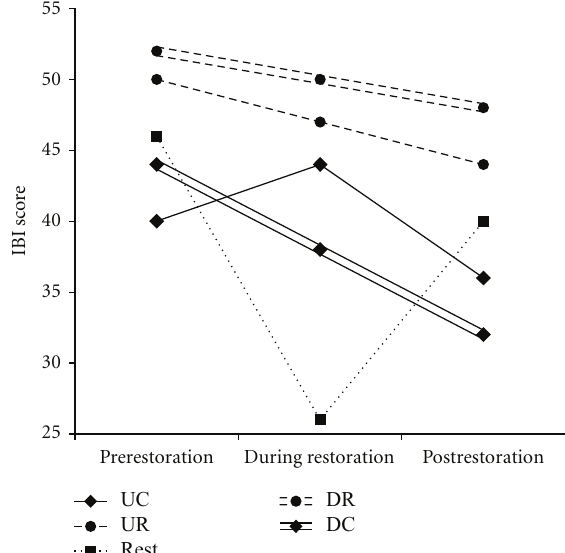
Figure 4: Fish community Index of Biotic Integrity scores for restoration, control, and reference reaches in the Cacapon River, WVa, USA based on an index suggested by Daniels et al. [19] Higher IBI scores indicate healthier communities. Upstream control (impaired reach, but not receiving restoration) denoted “UC”, downstream control denoted “DC”, upstream reference (unimpaired, natural reach) denoted “UR”, and downstream reference denoted “DR”. The restoration reach is denoted as “Rest”. Fishes were sampled before restoration (2009), during restoration (2010), and after restoration (2010).